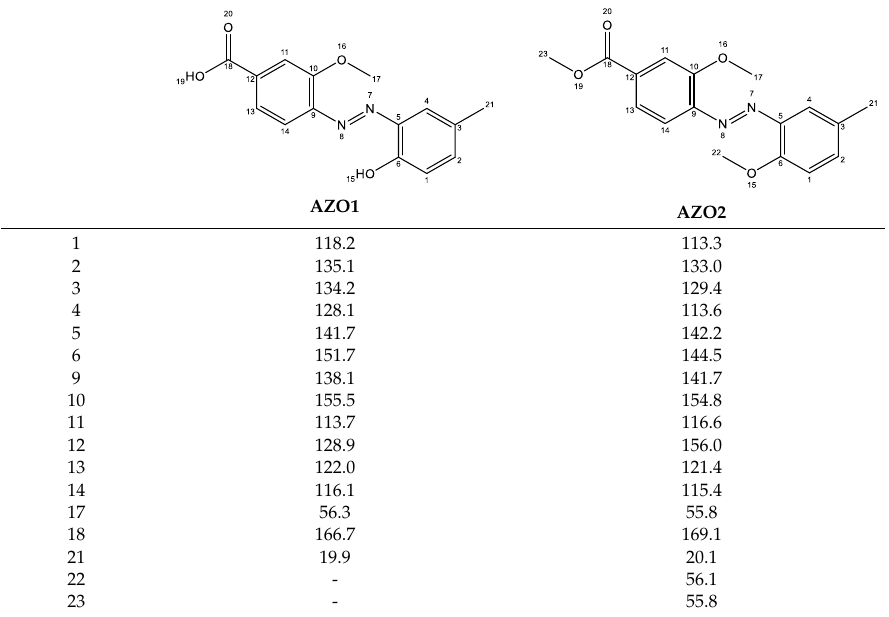
Table 1. 13 C NMR chemical shifts comparison of AZO1 and AZO2